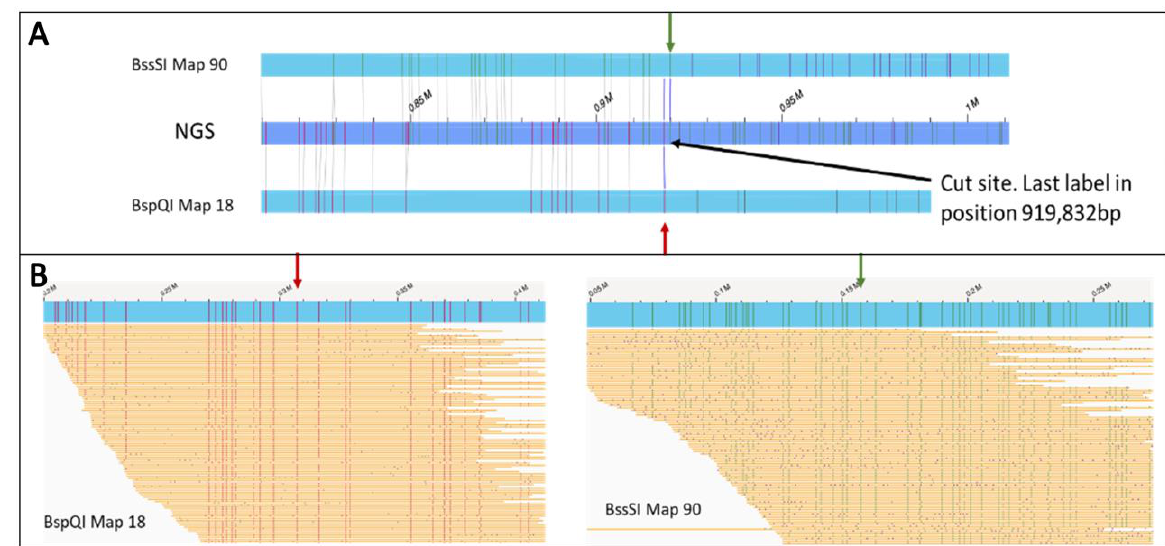
Figure 1. Example of inconsistency between optical maps and Hi-C-derived scaffolds in the H. lacustris assembly. ( A ) Alignment to the NGS assembly scaffolded with Hi-C. Red and green arrows indicate the incongruence points in the BspQI and the BssSI maps, respectively. ( B ) Raw Bionano molecules aligned on the two maps involved in the conflict.